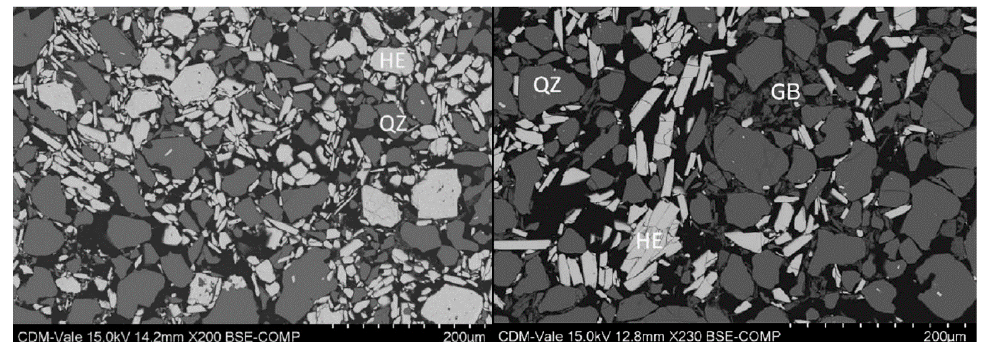
Figure 16. SEM images of two weathered itabirites from Abóboras Mine. HE = hematite, QZ = quartz, GB = gibbsite [28].